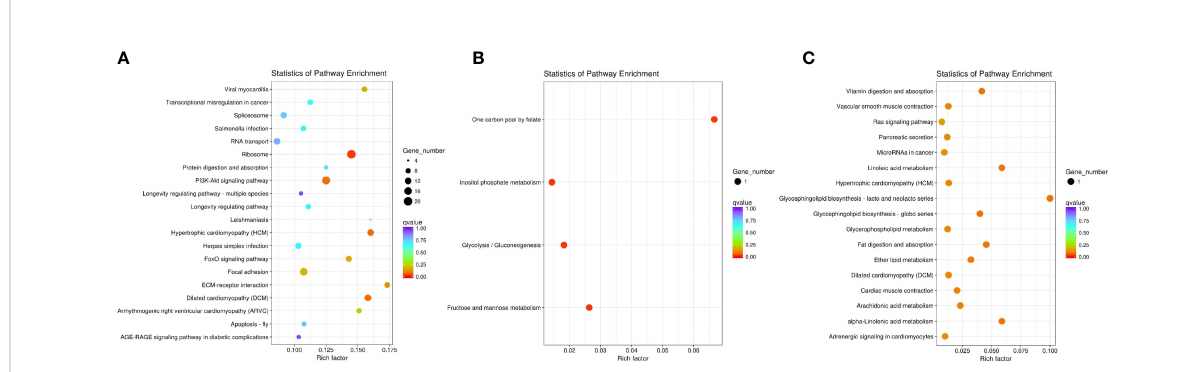
FIGURE 4 Enrichment of differentially expressed genes (DEGs) in KEGG (corrected P -value <0.05). (A) Downregulated DEGs that enriched KEGG terms in D2 dsGFP vs. D0dsGFP . (B) Downregulated DEGs that enriched KEGG terms in D0 dsETH vs. D0 dsGFP . (C) Upregulated DEGs that enriched KEGG terms in D2 dsETH vs. D2 dsGFP